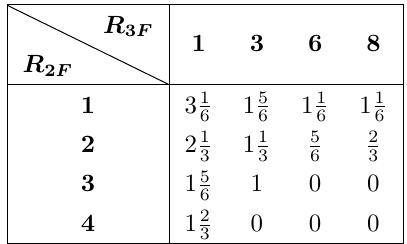
Table 2 . Maximal value of the hypercharge for which the SM gauge coupling g 1 remains pertur- bative up to 10 15 GeV . ( N = 2 and the VL mass is set at 10 TeV ). F